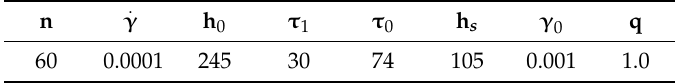
Figure 5. Comparison of the stress–strain curves between RVE simulation and experimental results. Table 1. Constitutive model parameters of ultra-thin 304 stainless steel foil.